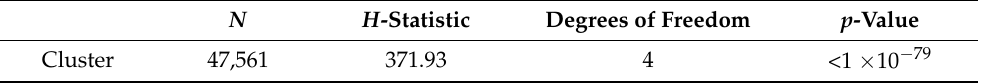
Table A5. Kruskal–Wallis test for stochastic dominance of the clusters’ RT score distribution. N H -Statistic Degrees of Freedom Cluster